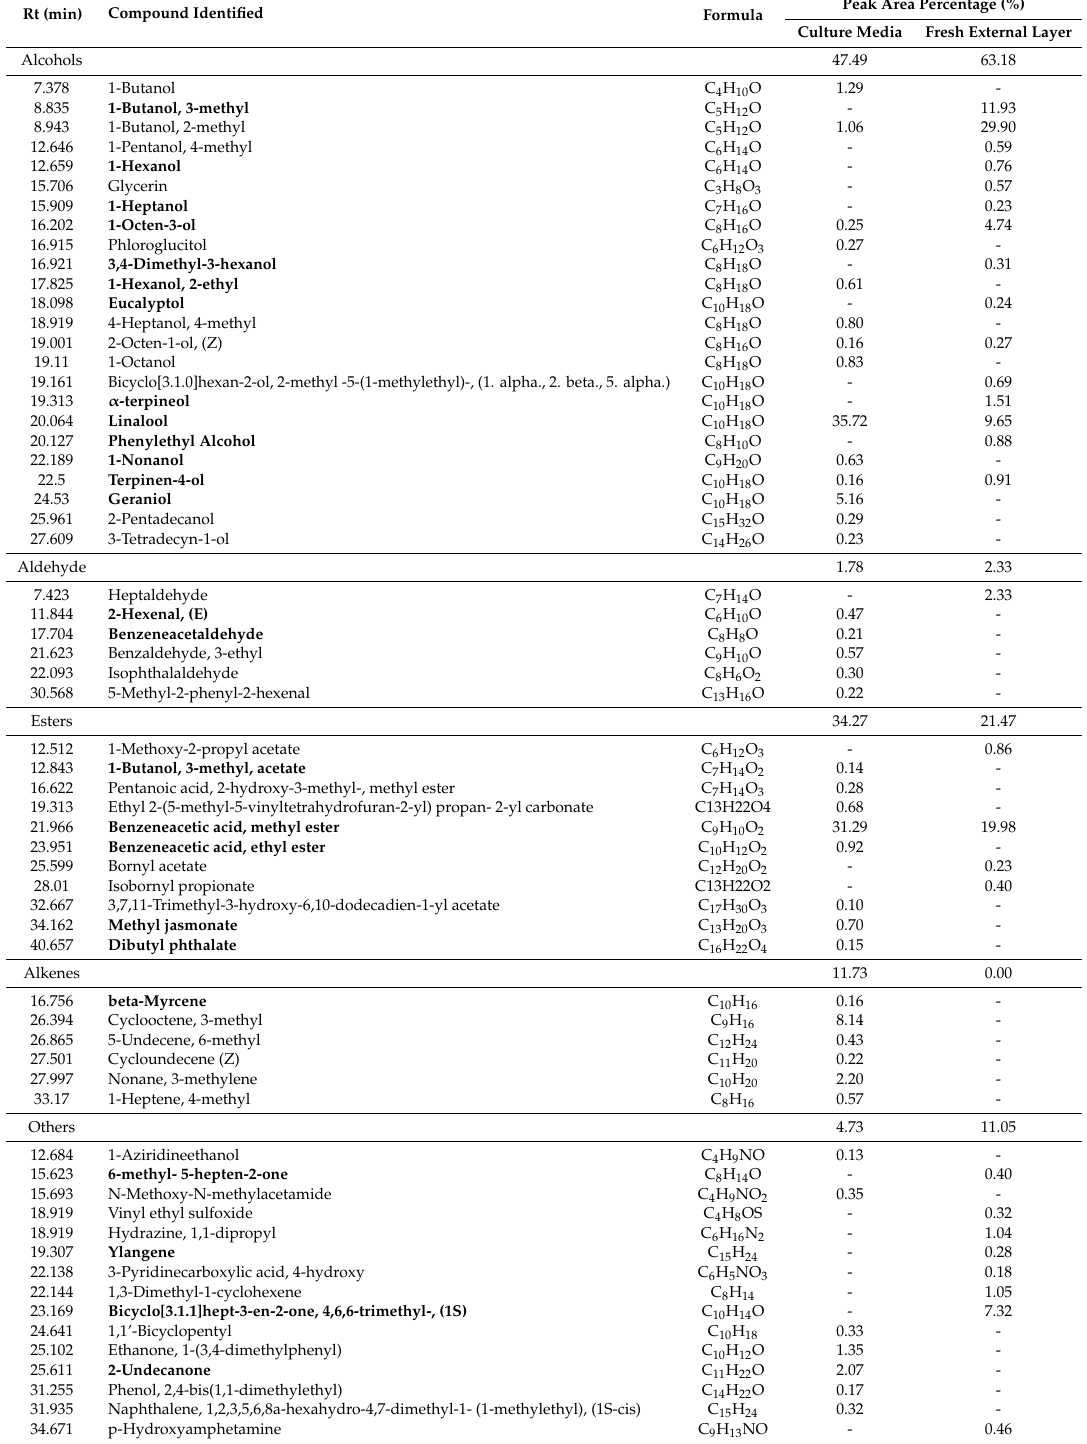
Table 2. Compounds identified in the essential oil extract of culture media and fresh external layer of cultivated sclerotium of P. cocos